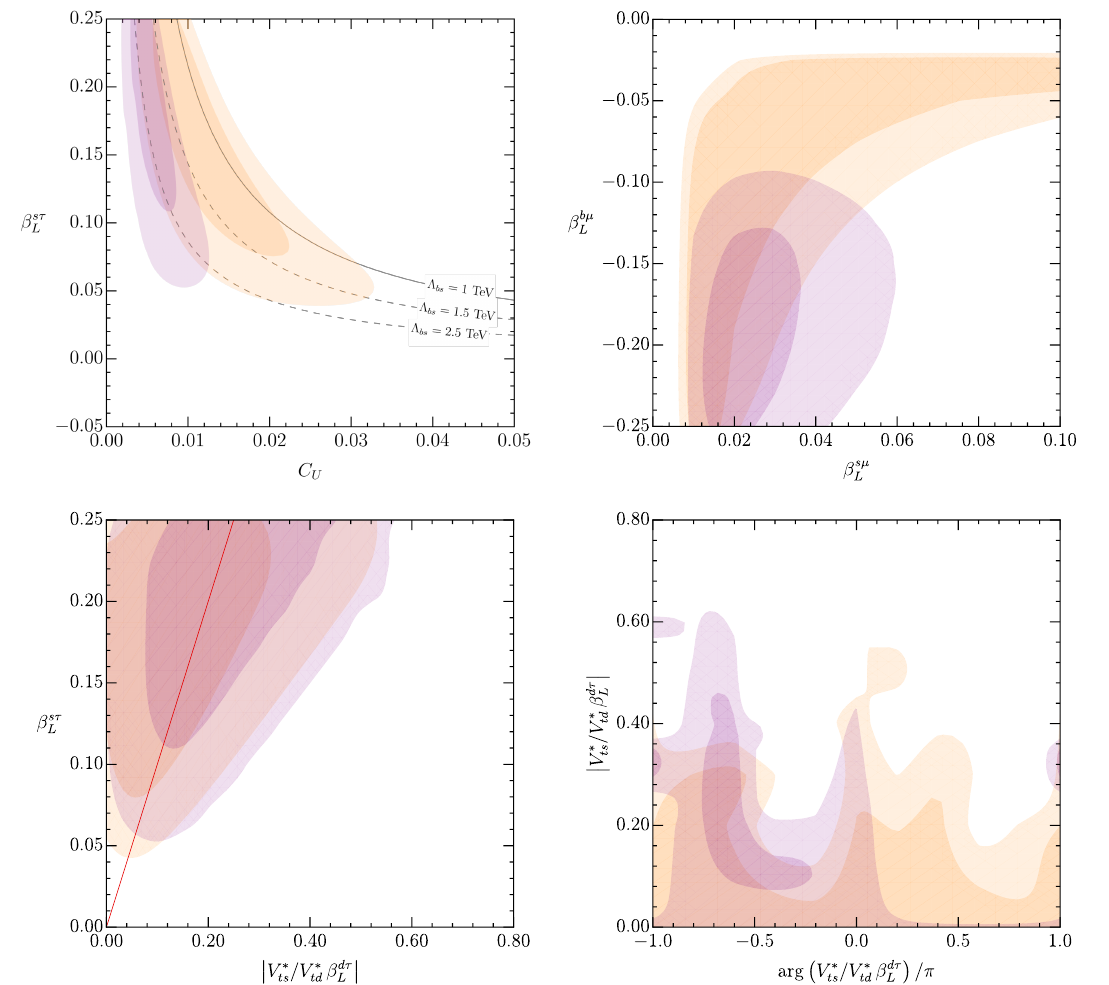
Figure 5 . Two-dimensional constraints on the U 1 couplings obtained by including the low-energy inputs in tables 1, 2 and 3. The two colors correspond to the benchmarks β bτ = − 1 (purple), with β dτ unconstrained. For each benchmark, the darker and lighter regions β bτ R L denote ∆ χ 2 ≤ 2 . 30 ( 1 σ ) and ∆ χ 2 ≤ 6 . 18 ( 2 σ ), respectively. In the C show dashed contour lines corresponding to δ (∆ m the β sτ - β dτ plot (lower left) the red solid line corresponds to the U(2) 5 relation β dτ L L